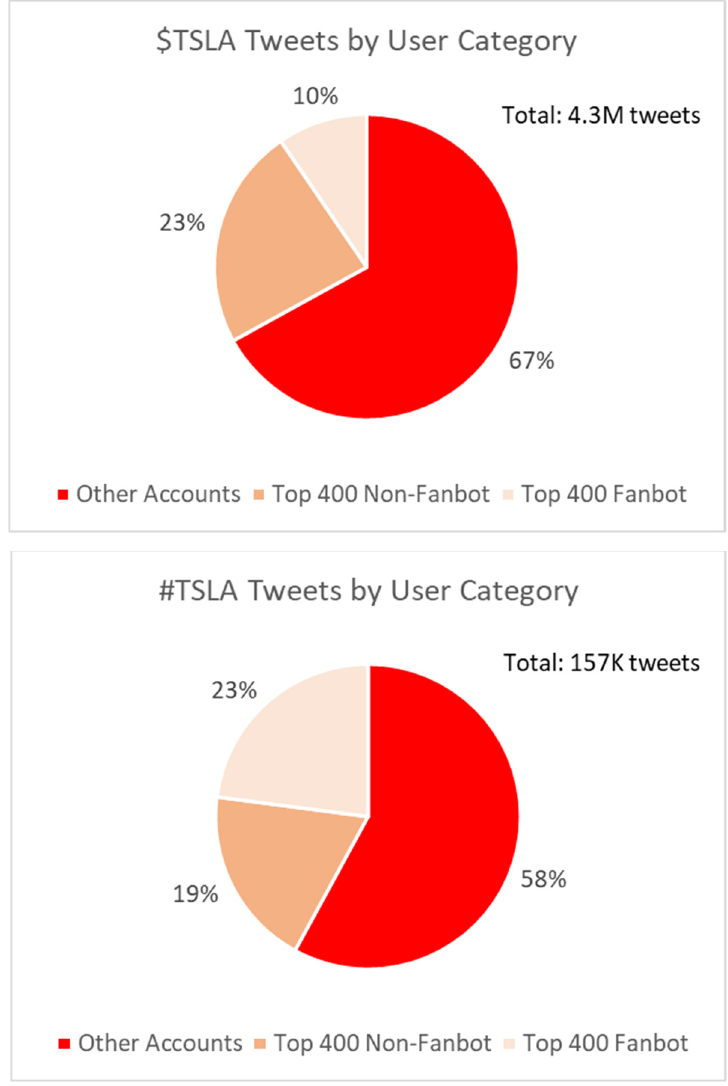
Figure 4. Distribution of $TSLA and #TSLA tweets by category of users.